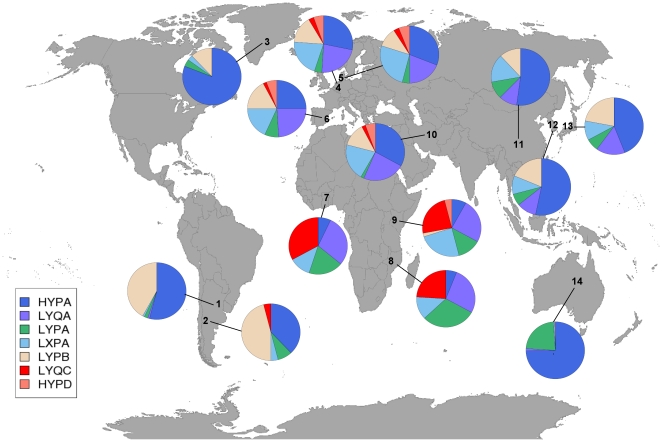
MBL2 haplotype frequencies in different populations.1, Argentina (Chiriguanos) [2]; 2, Argentina (Mapuche) [2]; 3, Greenland [2]; 4, The Netherlands [47]; 5, Denmark [2]; 6, Spain [48], 7; Ghana (present study); 8, Mozambique [2]; 9, Kenya [2]; 10, Iran [49]; 11, China [13]; 12, Korea [50]; 13, Japan [51]; 14, Australia [52].